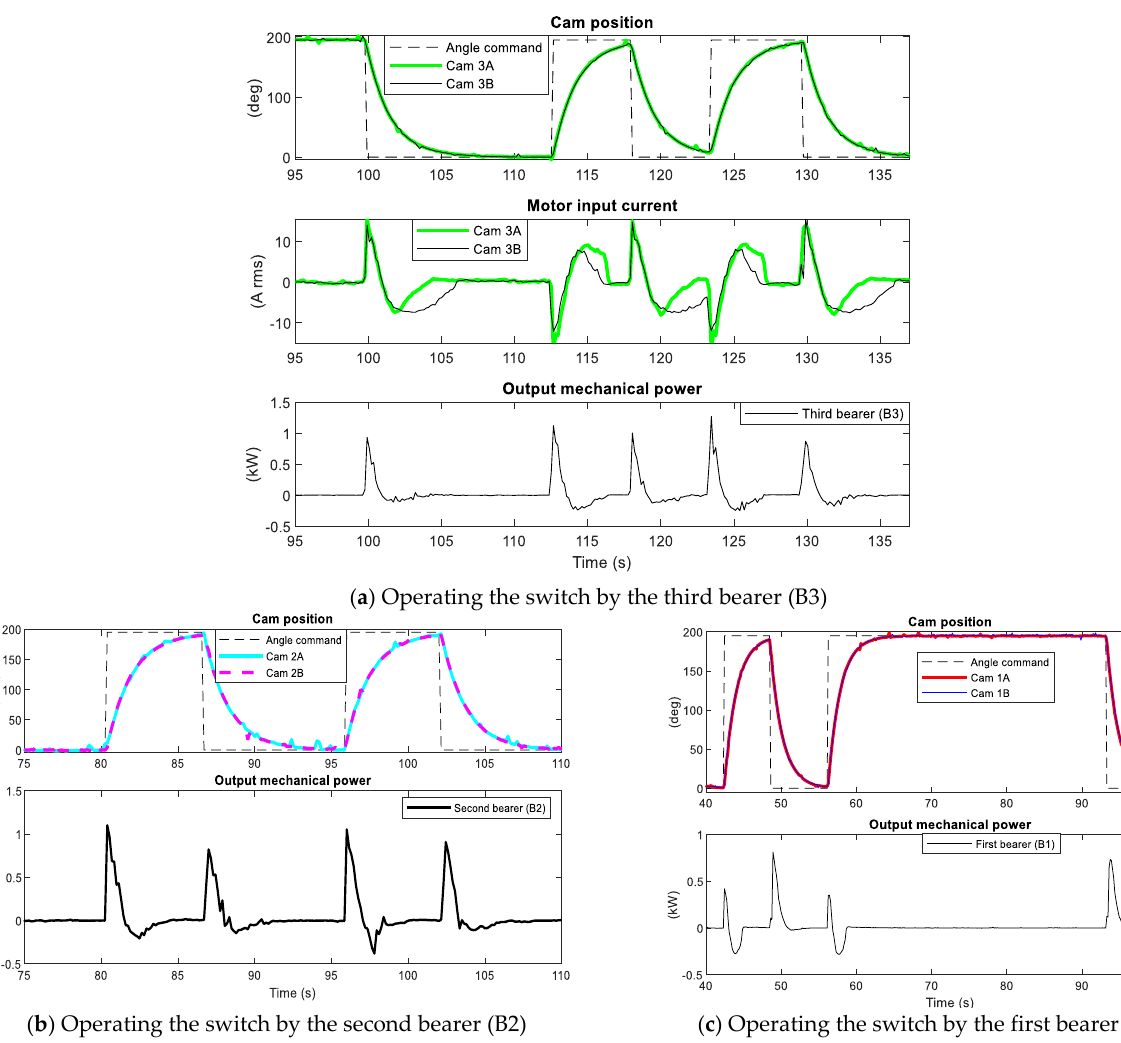
Figure 17. Performance of the track switch system running with single bearer at single actuation mode ( a – c ).